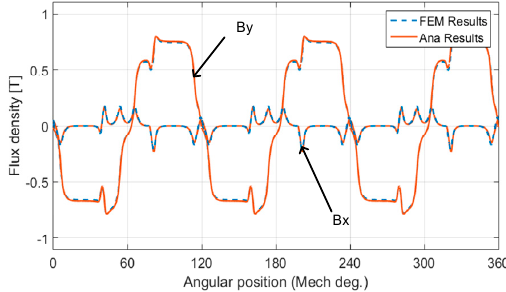
Figure 10. Axial and circumferential components of PM flux density at the center of air gap under rated load.